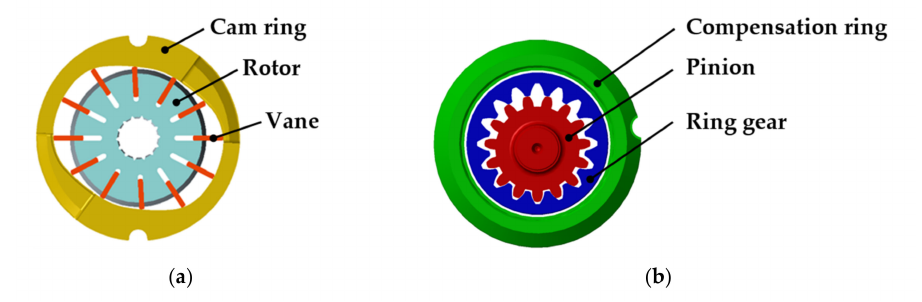
Figure 1. Inner parts of the BVP ( a ) and the IGP without a crescent ( b